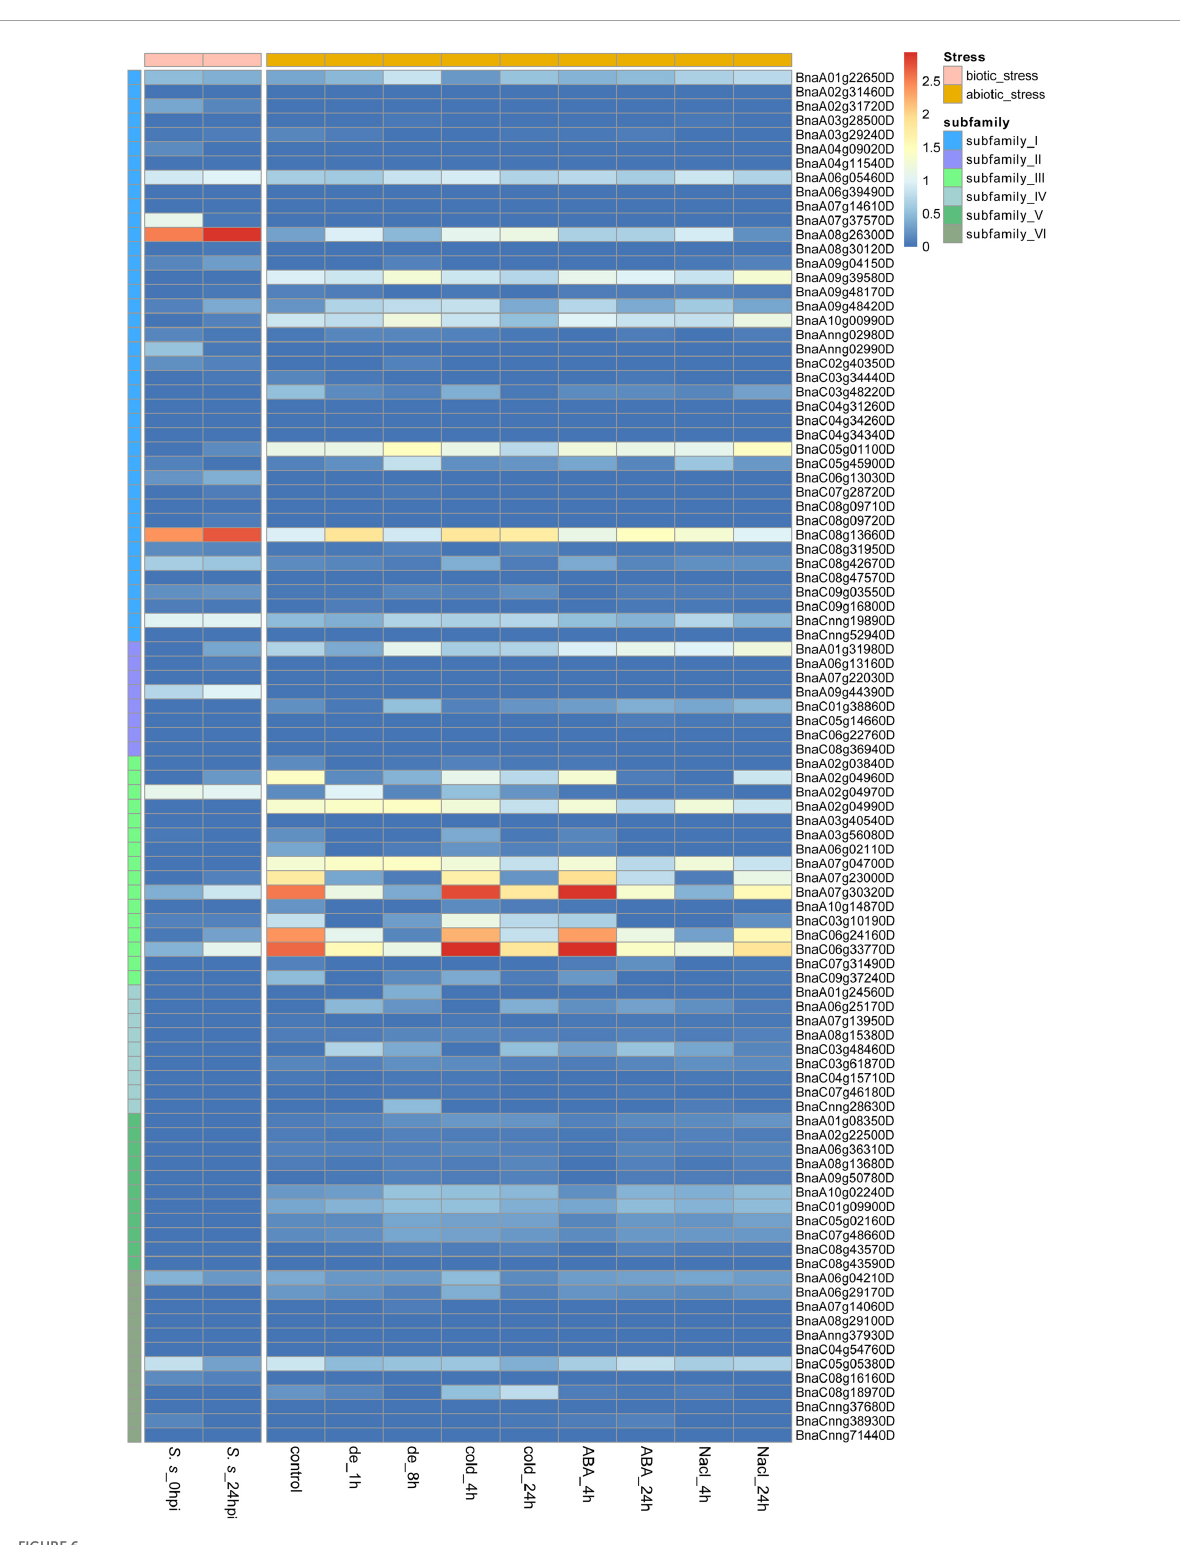
FIGURE6 Expression profiles of 96 BnCDP genes under biotic (left) and abiotic (right) stress conditions. The left panel shows the expression level of BnCDP genes in ZY821 at 0 and 24 h after Sclerotinia sclerotiorum inoculation; The left panel shows the expression level of BnCDP genes under different abiotic stress conditions (dehydration, cold, ABA and salinity). The expression data were processed with the log 10 normalization of fragments per kilobase million (FPKM). The color scale represents relative expression levels from low (blue color) to high (red